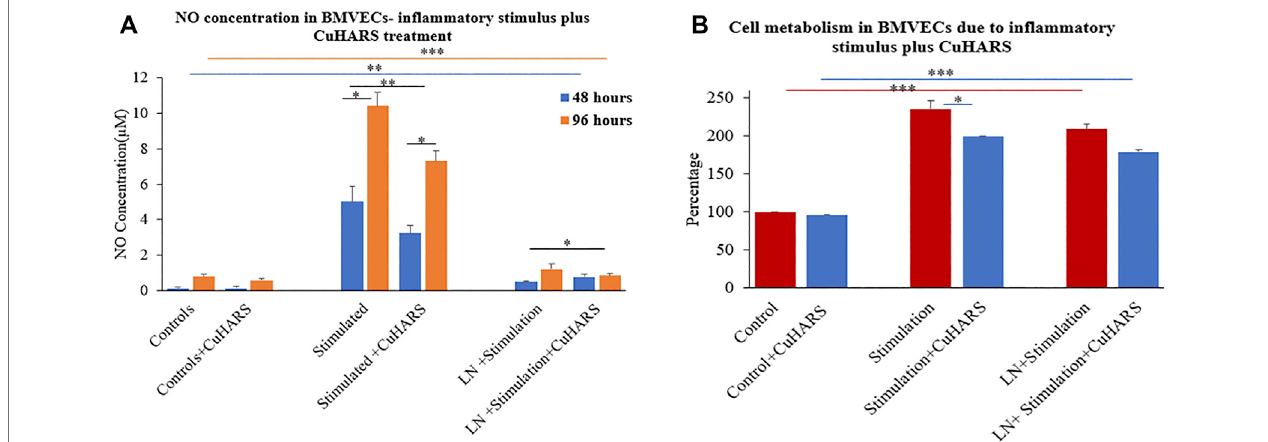
FIGURE 7 | Normal brain endothelial cell (BMVECs) response to 20 μ g/ml CuHARS treatment in the presence of in fl ammatory stimulations (100 ng/ml of TNF + 5 μ g/mlofLPS). (A) NOconcentrationinthecellsduetothetreatmentshowinginhibitioninNOreleaseinboth48-and96-htimepointinBMVECstreatedwithCuHARS compared to cells treated with in fl ammatory stimulus alone. The negative controls treated with LNAME, an NOS inhibitor, showed signi fi cant inhibition in NO release. (B) Cell metabolism due to the treatment showing signi fi cant increase in cell metabolism in BMVECs treated with in fl ammatory stimulus compared to the controls